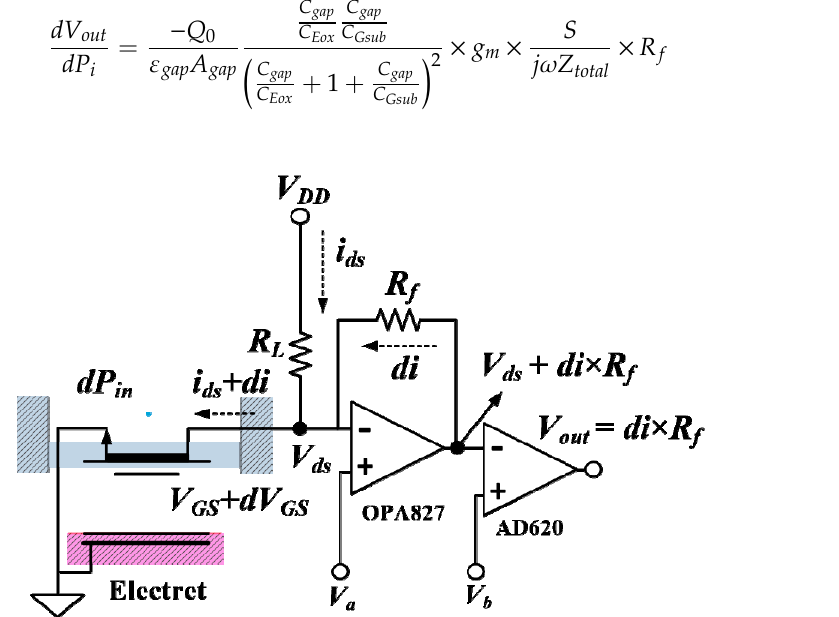
Figure 4. Schematic of the current–voltage ( I – V ) converter circuit. In the first stage, the drain supply voltage V DD and load resistor R L determine the operating point of the FET, while the feedback resistor R f represents the I – V transformation gain. In the second stage, AD620 works as an instrumentation amplifier to remove the direct current (DC) component in the output voltage.